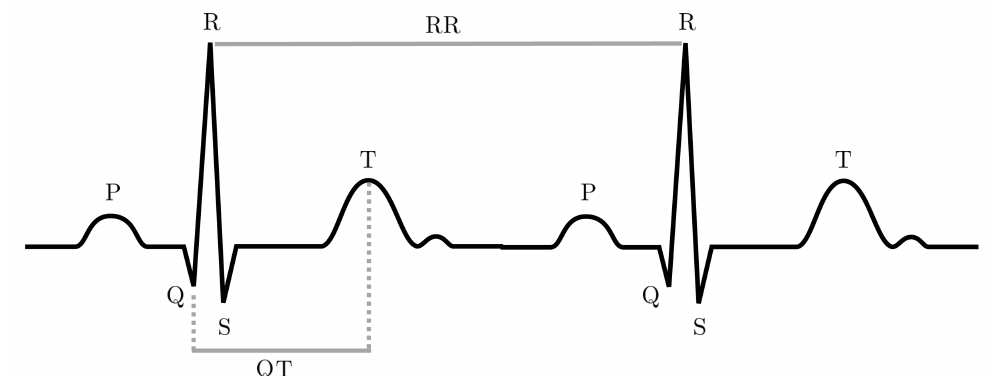
Figure 3. QRS complex in an ECG recording. RR: time between two consecutive R peaks (heart rate). QT: time between Q wave and T